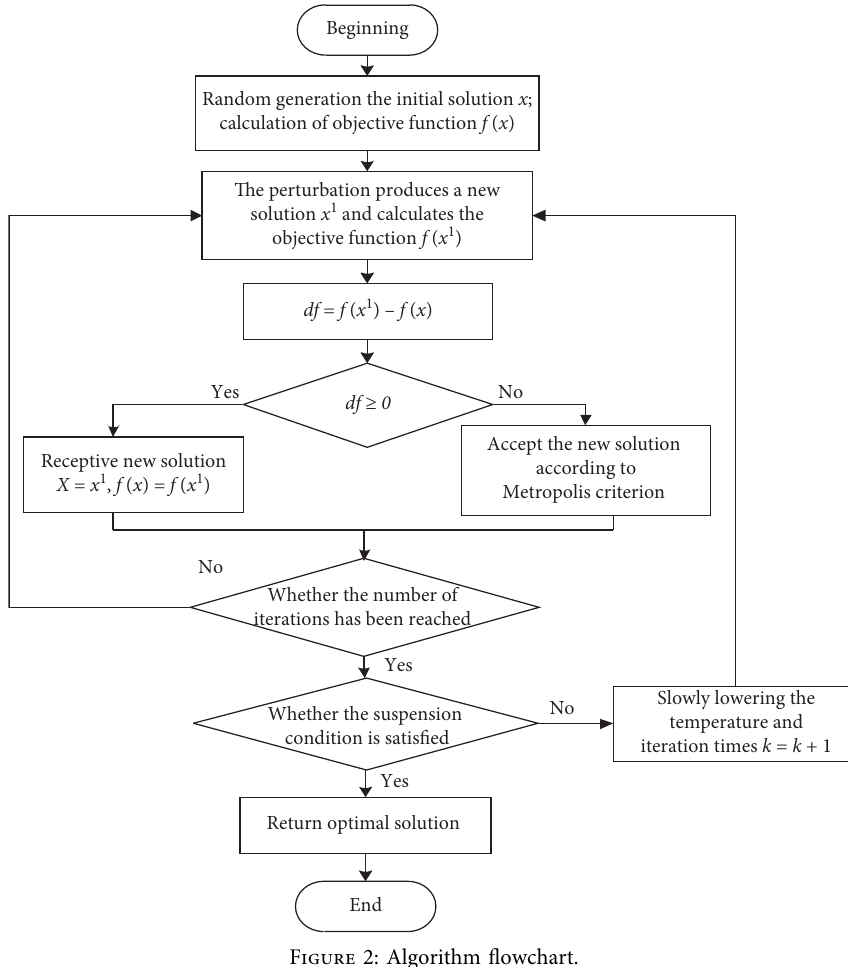
Figure 2: Algorithm